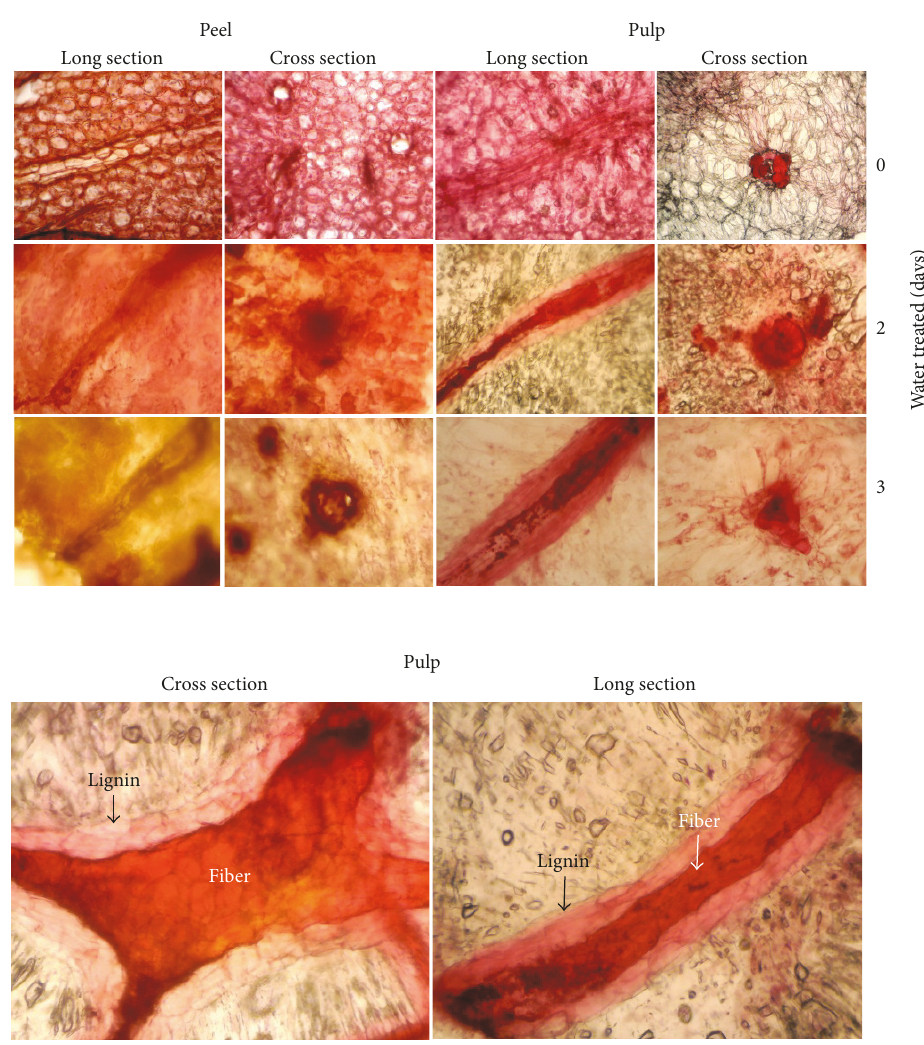
Figure 3: Histochemical structure staining in pericarp and aril of water-treated mangosteen